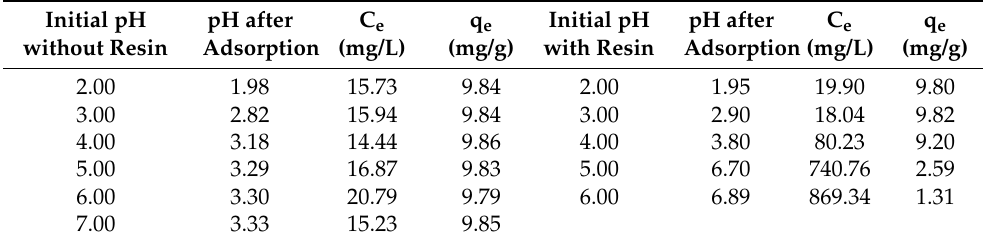
Table 2. Effect of pH in the solution with and without Dowex ® HCR-S on ectoine